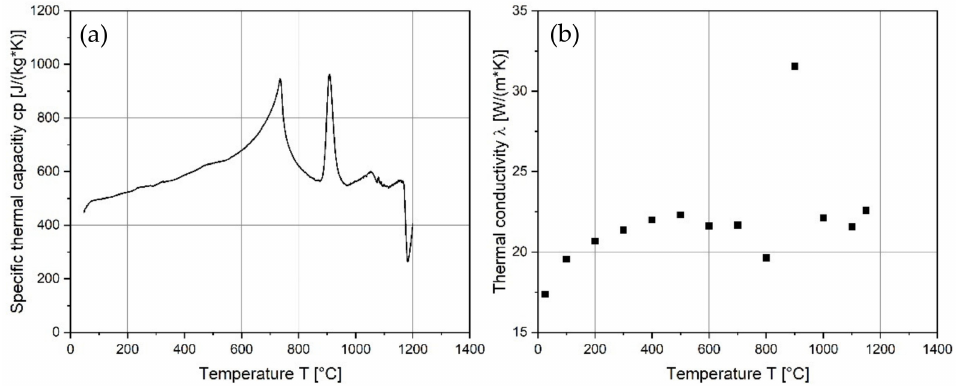
Figure 14. Physical properties of the as-built PBF-EB thin-walled cylinder for tool developments: ( a ) Specific thermal capacity c p ; ( b ) and conductivity λ